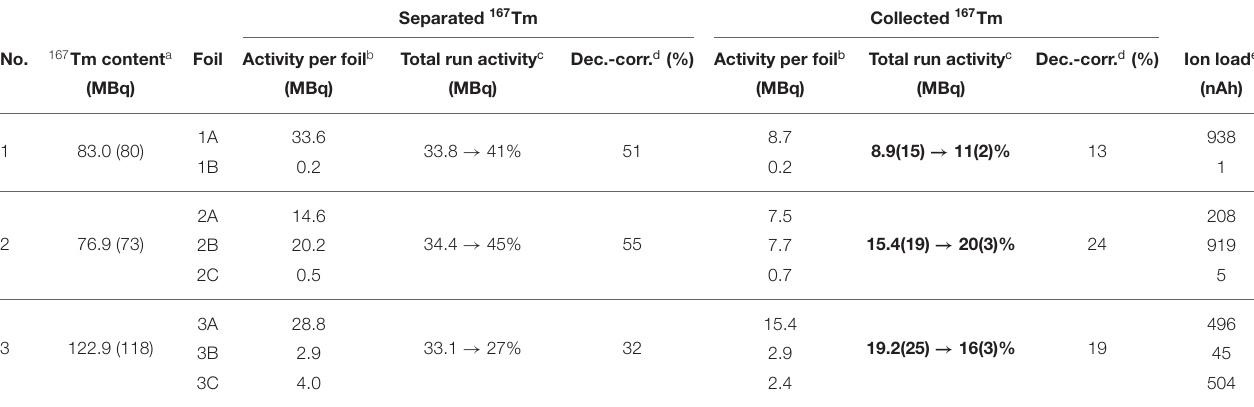
TABLE 1 | Overview of the three 167 Tm collections performed at MEDICIS. Separated 167 Tm Collected 167 Tm